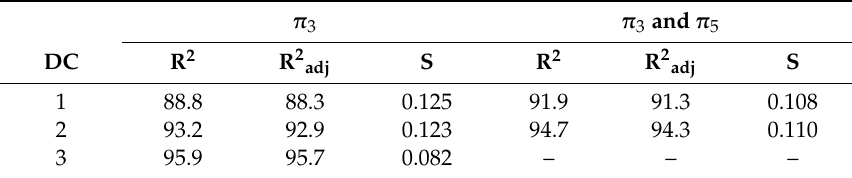
Table 9. Comparison of statistical significance for models with one variable ( π 3 ) and two variables ( π 3 and π 5 ).